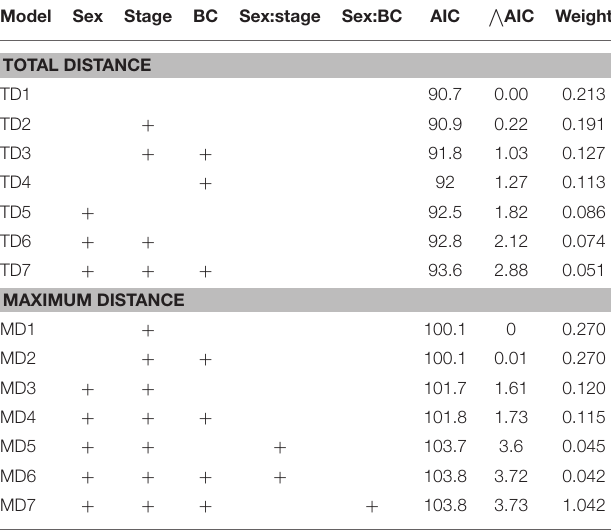
TABLE 2 | Linear models of the total distance traveled (TD) and maximum distance from the breeding colony (MD) for Cape gannets as a function of sex, stage of the breeding season (stage), body condition (BC) and the interaction between sex and stage and sex and BC.